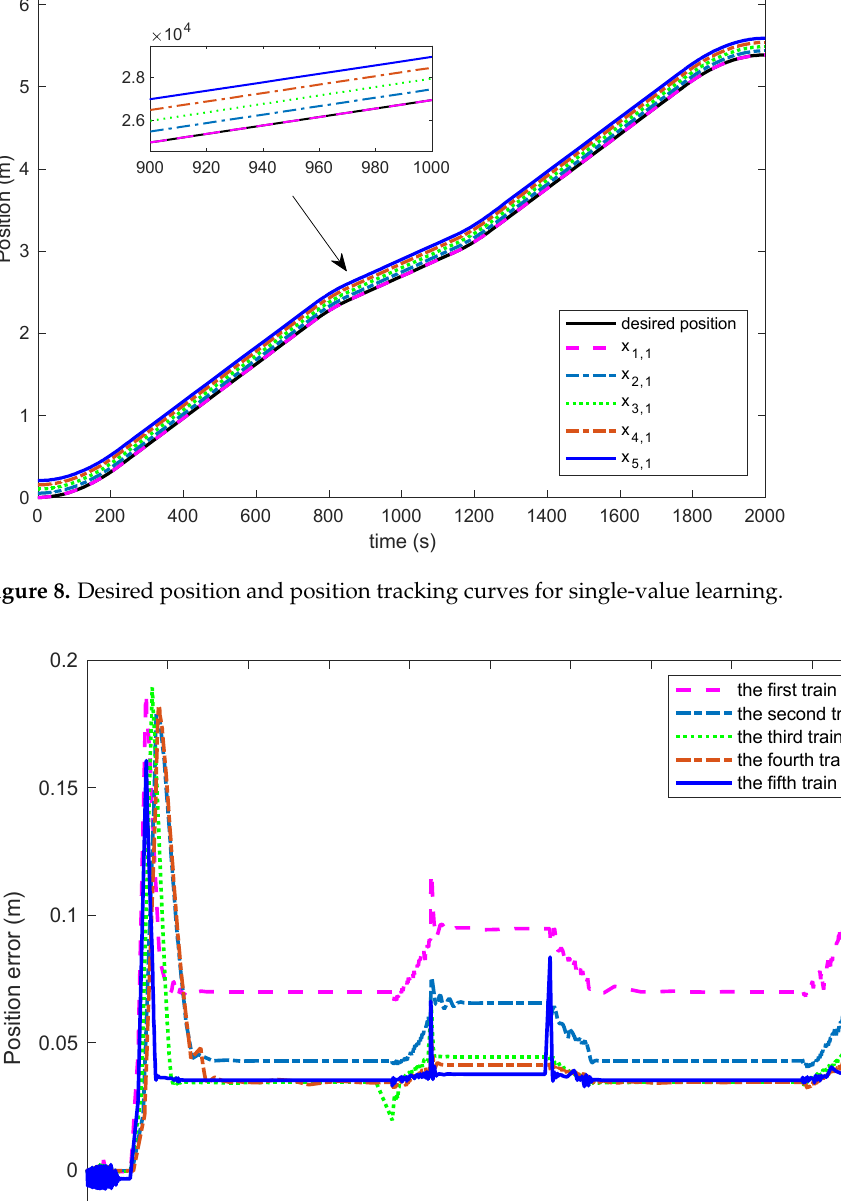
Figure 7. Estimated parameter curves for single-value learning.